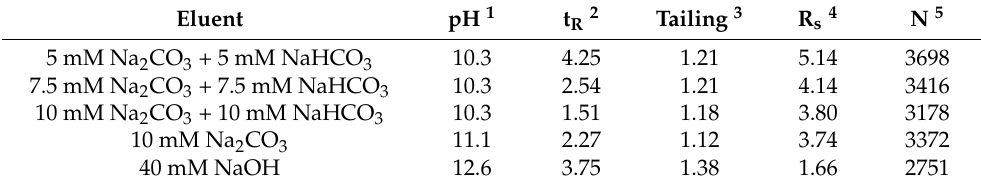
Figure 2. Chromatograms recorded during the screening of eluent conditions, using ( a ) 5 mM Na 2 CO 3 + 5 mM NaHCO 3 , ( b ) 7.5 mM Na 2 CO 3 + 7.5 mM NaHCO 3 , ( c ) 10 mM Na 2 CO 3 + 10 mM NaHCO 3 , ( d ) 10 mM Na 2 CO 3 , ( e ) 40 mM NaOH. Analyte concentrations; foscarnet 20 mg/L, phos- phate 5 mg/L, phosphite 10 mg/L, impurity-B 20 mg/L. Table 1. Summary of conditions and results from initial screening of eluents for development of foscarnet